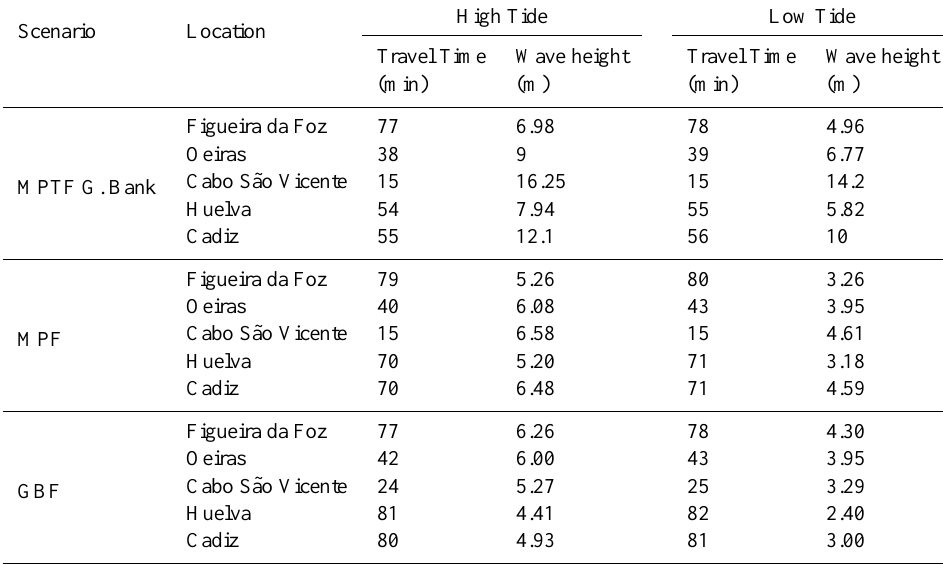
Table 4. Results for selected